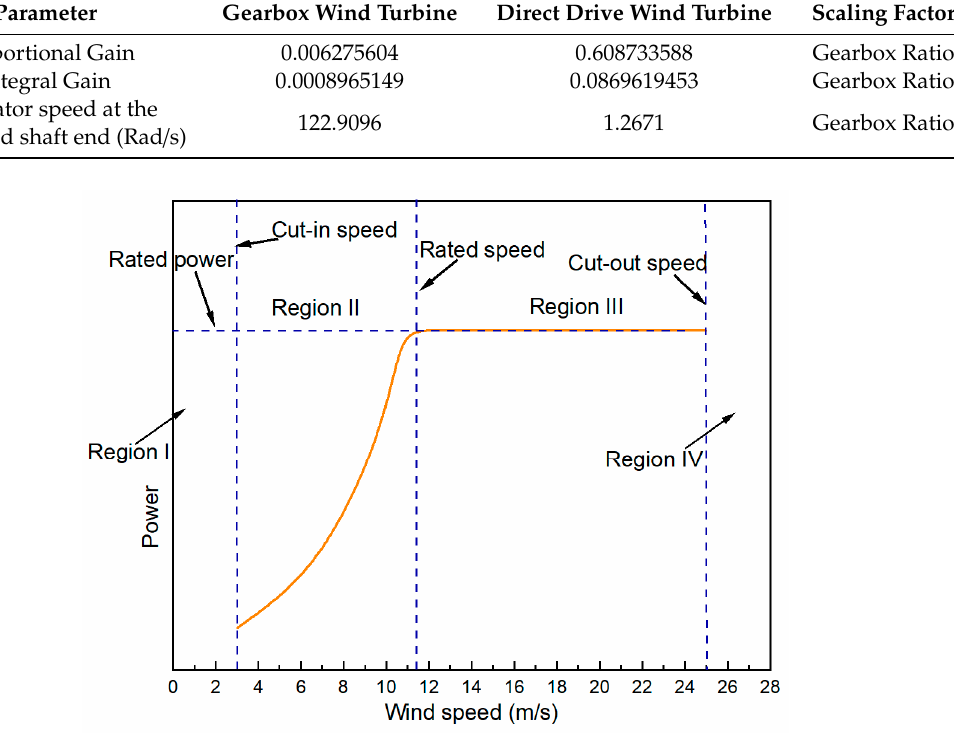
Figure 7. Regions of operations.